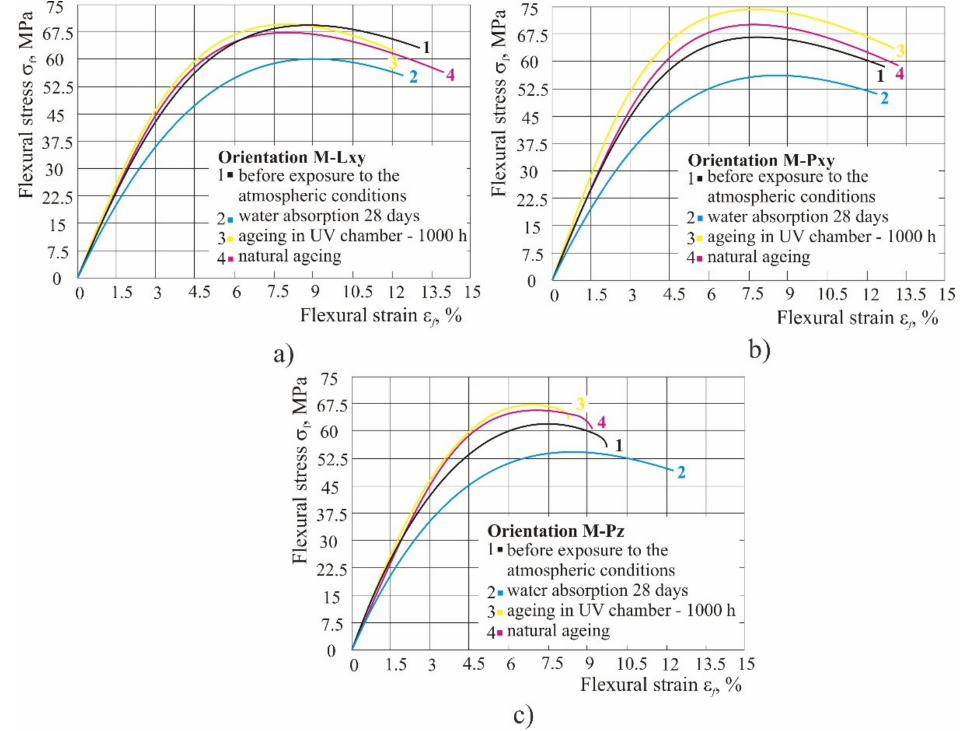
Figure 13. Impact of different atmospheric conditions on mixed material: ( a ) orientation Lxy, ( b ) orientation Pxy, ( c ) orientation